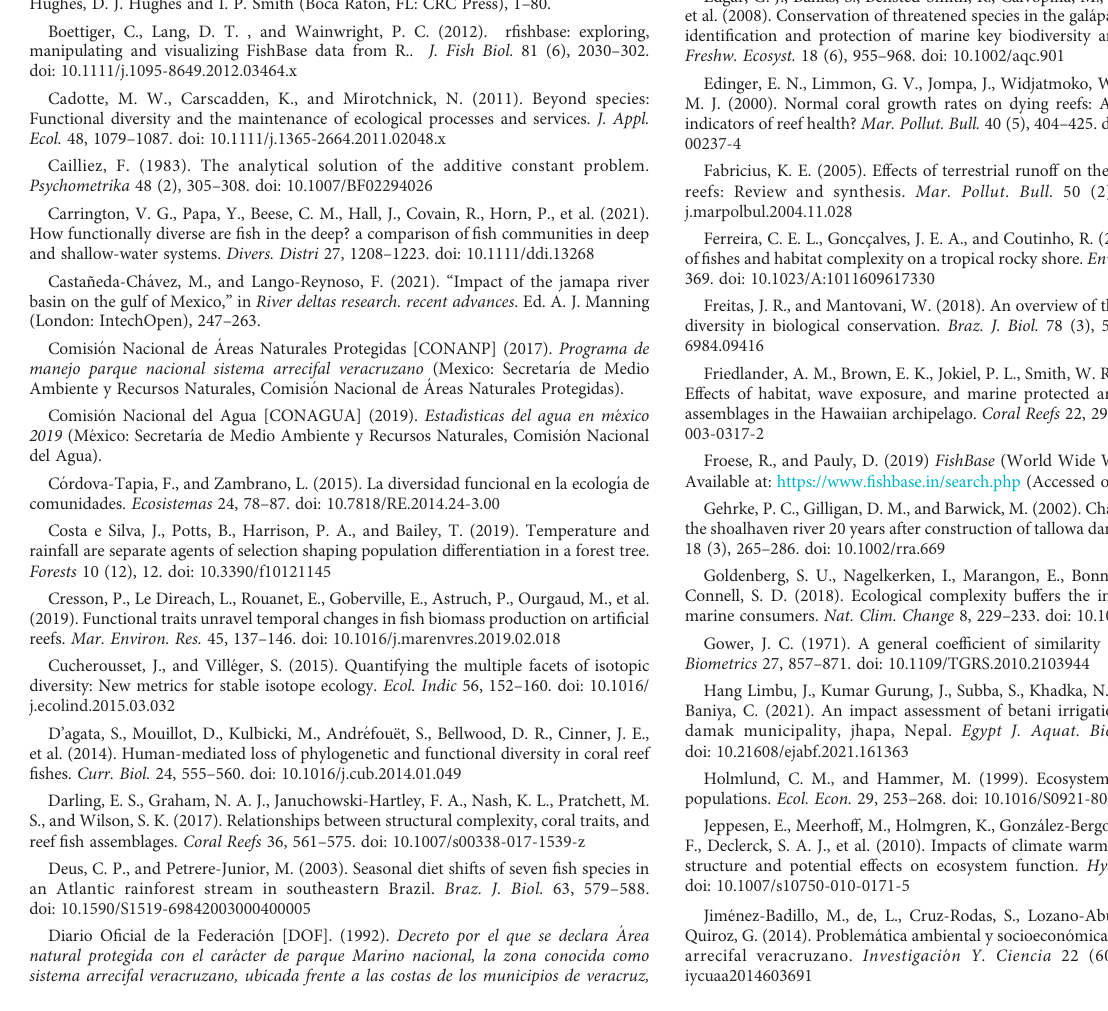
SUPPLEMENTARY FIGURE 2 Spearmanrankcorrelationanalysis(rho)betweenmetrics of fi shfunctional diversity, and the number of species (Nb_sp). (A) Number of species vs. functional richness (FRic). (B) Numberofspeciesvs.functionaldivergence(FDiv). (C) Numberofspecies vs. functional evenness (FEve). (D) FDiv vs. FRic. (E) FEve vs. FRic. (F) FEve vs. FDiv. SUPPLEMENTARY FIGURE 3 Position of 149 reef fi sh species of Parque Nacional Sistema Arrecifal Veracruzano community are represented along four functional axes. Vertices of the convex hull are in purple whereas non-vertices are in green